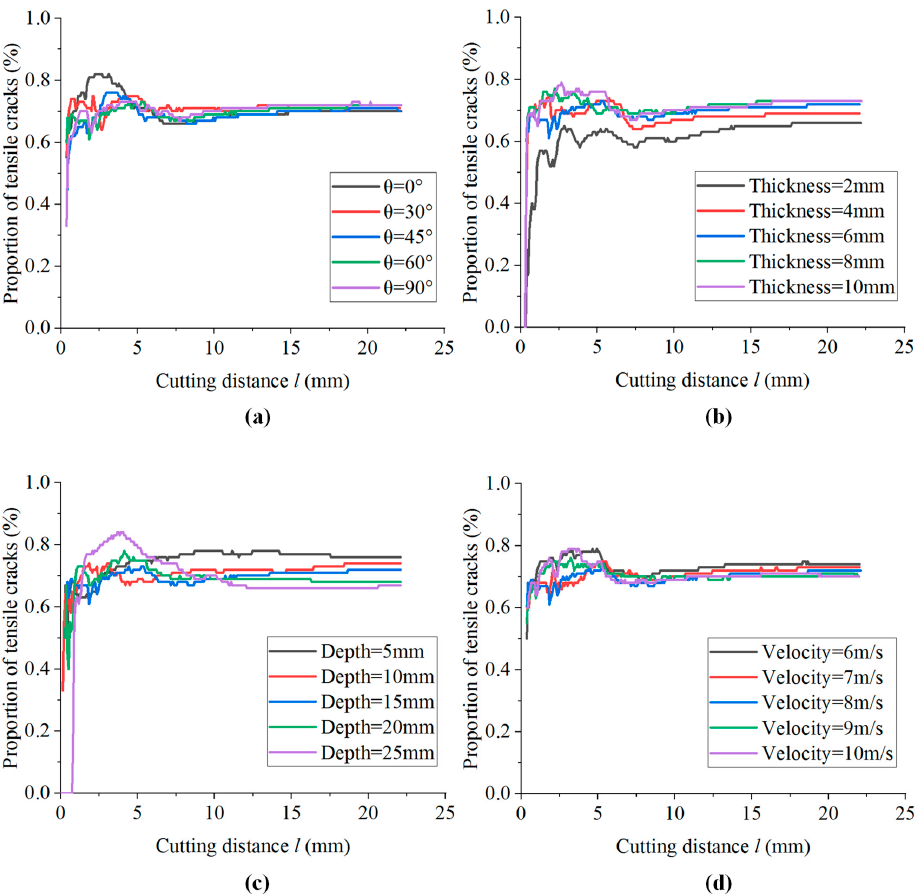
Figure 24. The change in the proportion of tensile cracks in the specimen with cutting distance under different influence factors. ( a ) Effect of bedding dips on the proportion of tensile cracks; ( b ) effect of bedding thicknesses on the proportion of tensile cracks; ( c ) effect of cutting depths on the proportion of tensile cracks; ( d ) effect of cutting rates on the proportion of tensile cracks. When the sample reaches the same cutting displacement, 22.1 mm, the percentage of tensile cracks and shear cracks and the number of total cracks change with different levels of various factors are as shown in Figure 25. This figure shows that, when the bedding angle and bedding thickness increase, the proportion of tension cracks shows a slight in- creasing trend, and the total number of cracks in both fluctuates. When the bedding angle is 30° and the bedding thickness is 4 mm, the total number of cracks reaches the maximum, respectively. When the cutting depth and cutting rate increase, the percentage of tensile cracks slightly decreases, and the total number of cracks in both cases linearly increases. When the cutting depth is 25 mm, and the cutting speed is 10 m/s, the total number of cracks reaches the maximum, respectively. In conclusion, when the bedding angle is small, the bedding thickness is small, the cutting depth is large, and the cutting speed is large, the specimen is more likely to be damaged under the cutting action. However, in practical projects, the life of the bit should be considered and the drilling parameters should be reasonably set.